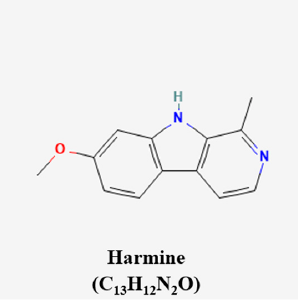
Table 5. Natural Products inhibiting angiogenesis.